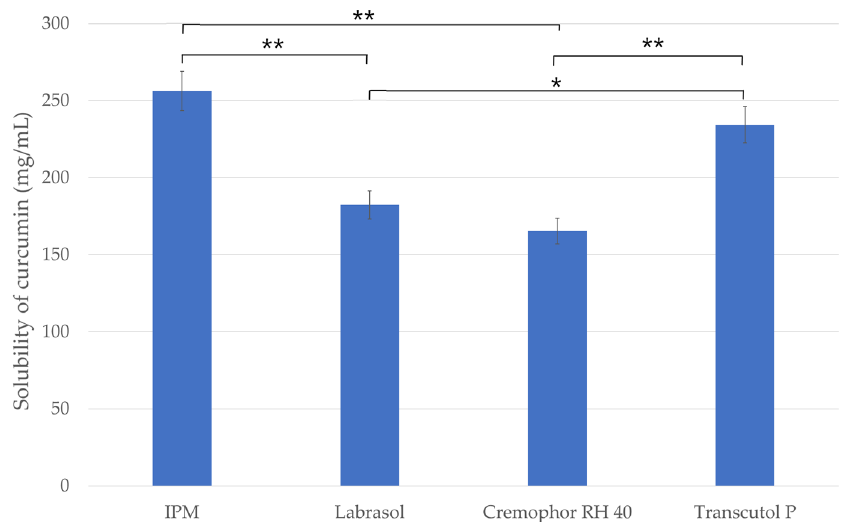
Figure 1. Screening of oil, surfactants and co-surfactant based on the solubility of curcumin. Ordinary one-way ANOVA and Tukey’s multiple comparison tests were performed to compare the formulations with each other. The * and ** indicate statistically significant differences at p < 0.05 and p < 0.01.